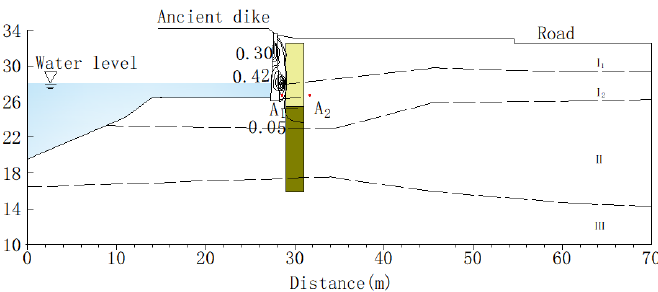
Figure 19. Distribution of hydraulic gradient after modified lime grouting between ancient dike and antiseepage wall.